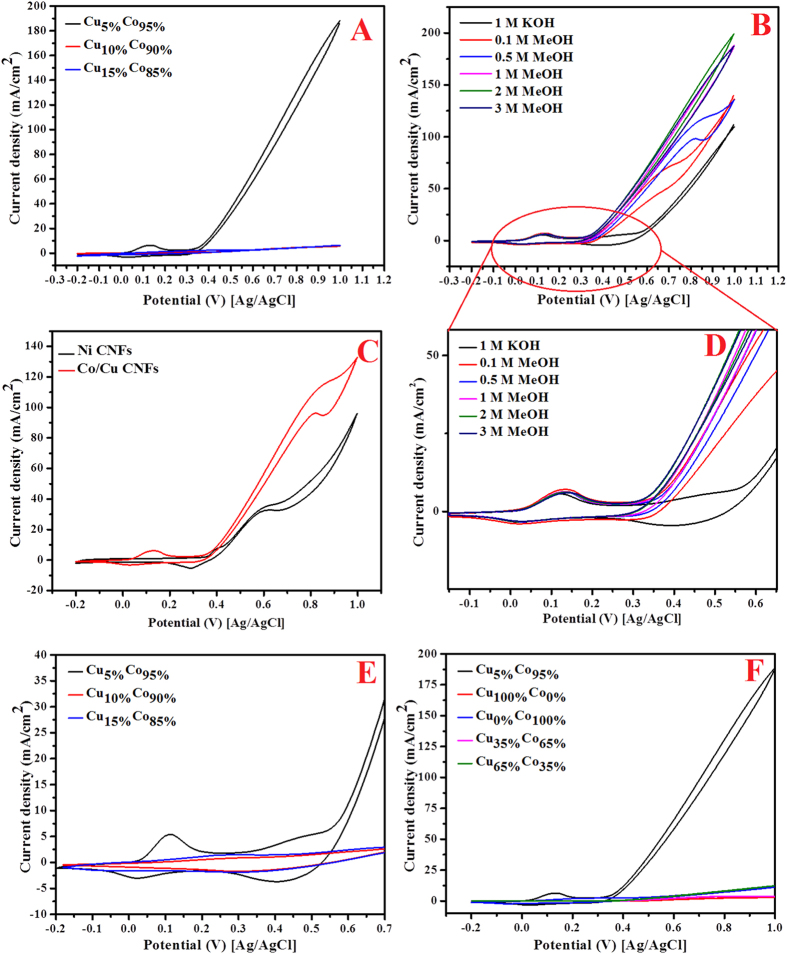
(A) Study the influence of Cu percentage on the electrocatalytic activity of the prepared CNFs containing (Cu5%Co95%, Cu10%Co90% and Cu15%Co85%) toward methanol (3 M in 1 M KOH) oxidation (B) CV for the Cu5%Co95%-CNFs at different concentration of methanol (C) Performances of Cu5%Co95% and Ni- decorated CNFs as electrocatalysts for(0.5 M in 1 M KOH) methanol oxidation (D) high magnification to show the onset potential (E) CV for 25 cycles during the activation process in presence of 1 M KOH (Scan rate 100 mV/s) for the carbon nanofibers containing Cu5%Co95%, Cu10%Co90% and Cu15%Co85% nanoparticles and (F) Study the influence of various percentages of Cu and Co on the electrocatalytic activity of the prepared CoCu-CNFs toward methanol oxidation (3 M in 1 M KOH) at scan rate 50 mV/s at 25 °C.